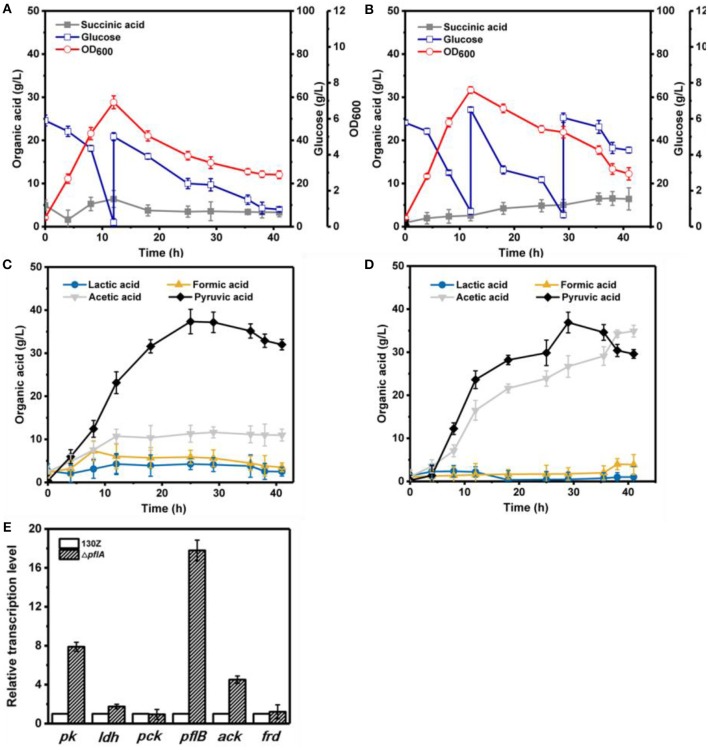
Evaluation of different fermentation and metabolic parameters in the 130Z strain (A,C) compared to those of the ΔpflA strain (B,D) under aerobic conditions. The bar graph (E) represents the expression levels of genes related to organic acid biosynthesis pathway.